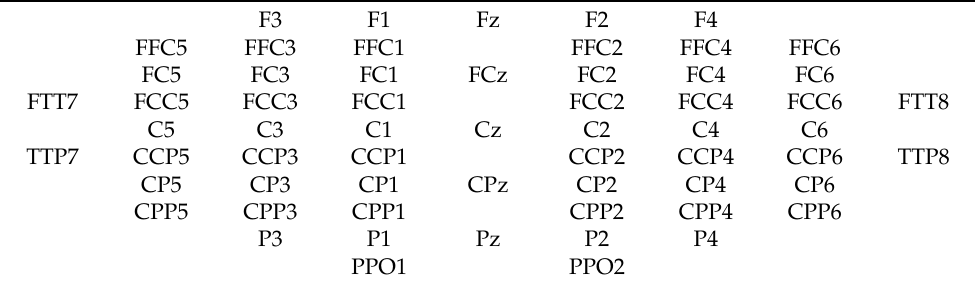
Table 1. Spatial arrangement of input channels at each timestep. The blank entries are filled with 0 s. F3 F1